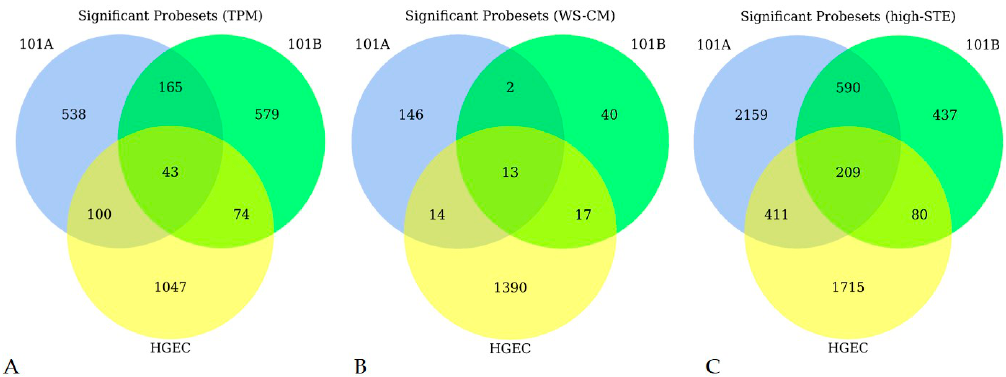
Figure 2. Venn diagrams showing the number of significant probe sets for each treatment in each cell line. ( A ) Under total particulate matter (TPM) condition; ( B ) Under whole-smoke conditioned media (WS-CM) condition; ( C ) Under high-smokeless tobacco extract (high-STE). Blue circle = 101A, green circle = 101B, and yellow circle = human gingival epithelial cell (HGEC). Table 2. Six common genes that are robustly upregulated by total particulate (TPM) and whole-smoke conditioned media (WS-CM) in all 3 cell lines.